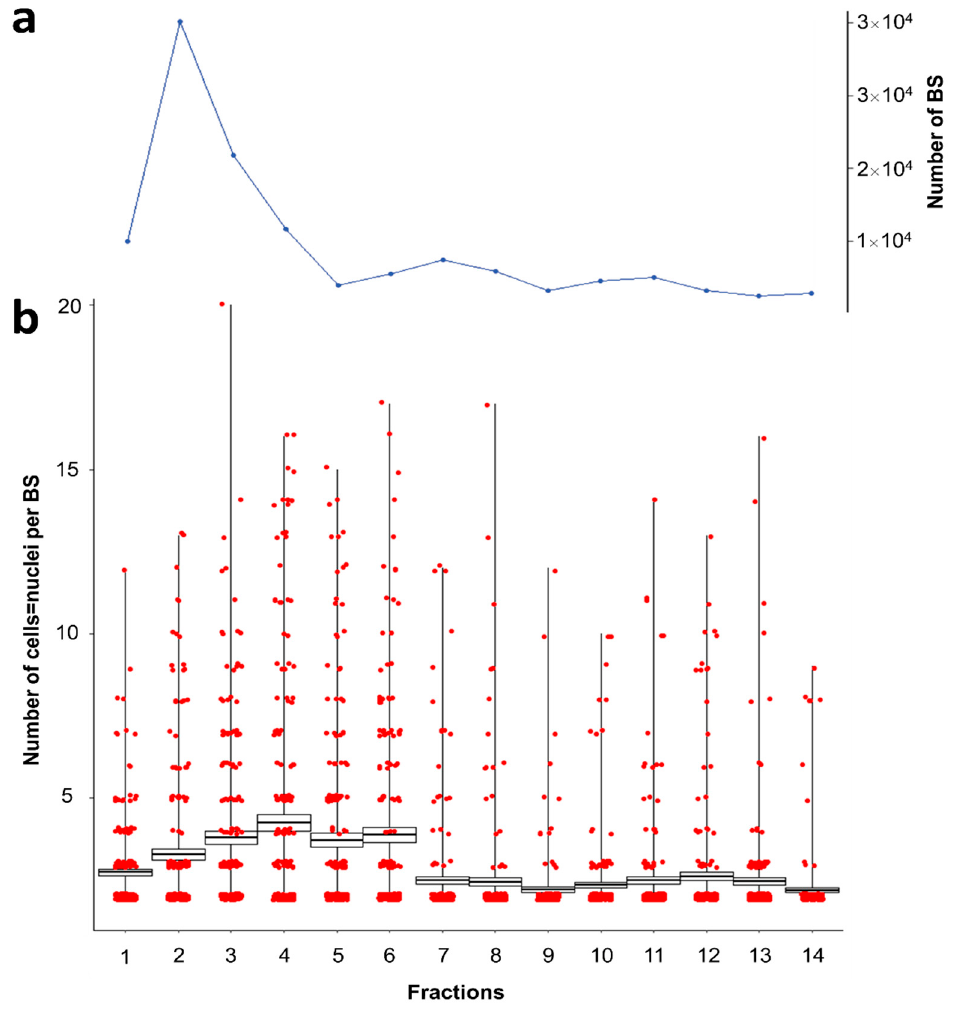
Figure 3. S. molnari BS sorting by size/cellularity: 14 fractions of 5 mL were collected from DEAE-C column (RPMIsalt, 5 mL column height). ( a ) Quantity of parasites per fraction. ( b ) Cellularity of S. molnari BS per fraction, estimated from number of DAPI-stained nuclei of 200 BS per fraction. Box plots represent the average number of cells/nuclei ± standard error (box) with maximum and minimum ranges (whiskers). Red circles represent jittered raw data from individual fractions.